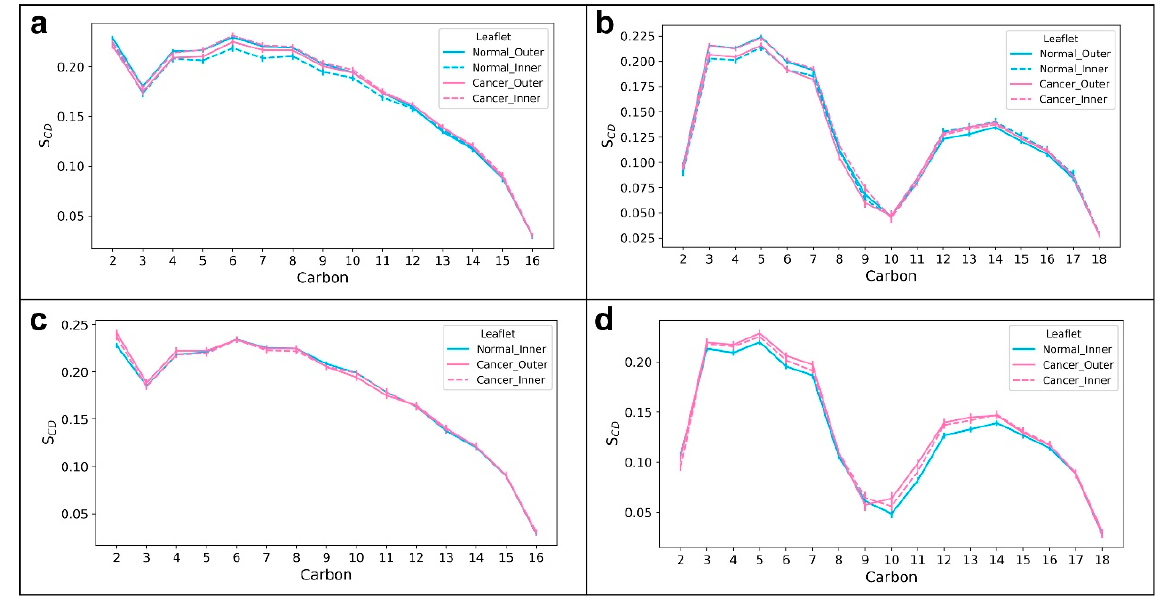
Figure 5. Order parameters of hydrophobic tails of lipid molecules in equilibrated systems : (a) POPC sn1, (b) POPC sn2, (c) POPS sn1 and (d) POPS sn2. The outer and inner leaflets of a normal membrane are shown in solid cyan and dashed cyan lines, respectively. The outer and inner leaflets of a cancer membrane are shown in solid magenta and dashed magenta lines, respectively.